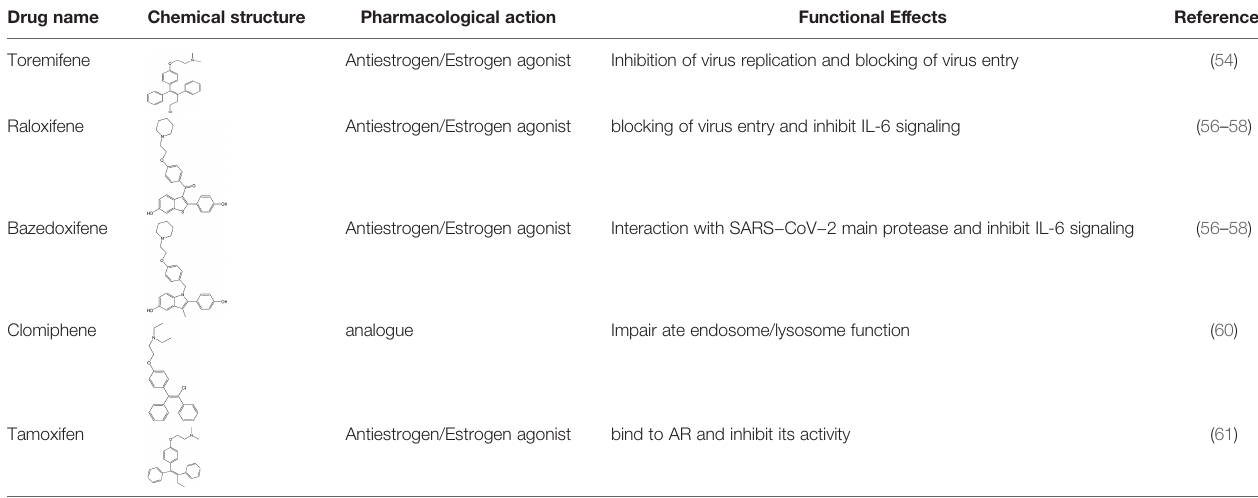
TABLE 1 | Effect of SERMs on the biology of SARS − CoV −